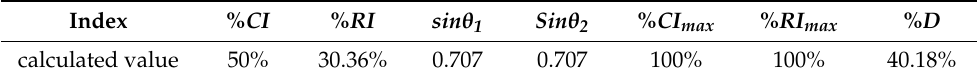
Table 10. D-distance calculation of HVCB#2 by using the evaluated % CI and % RI